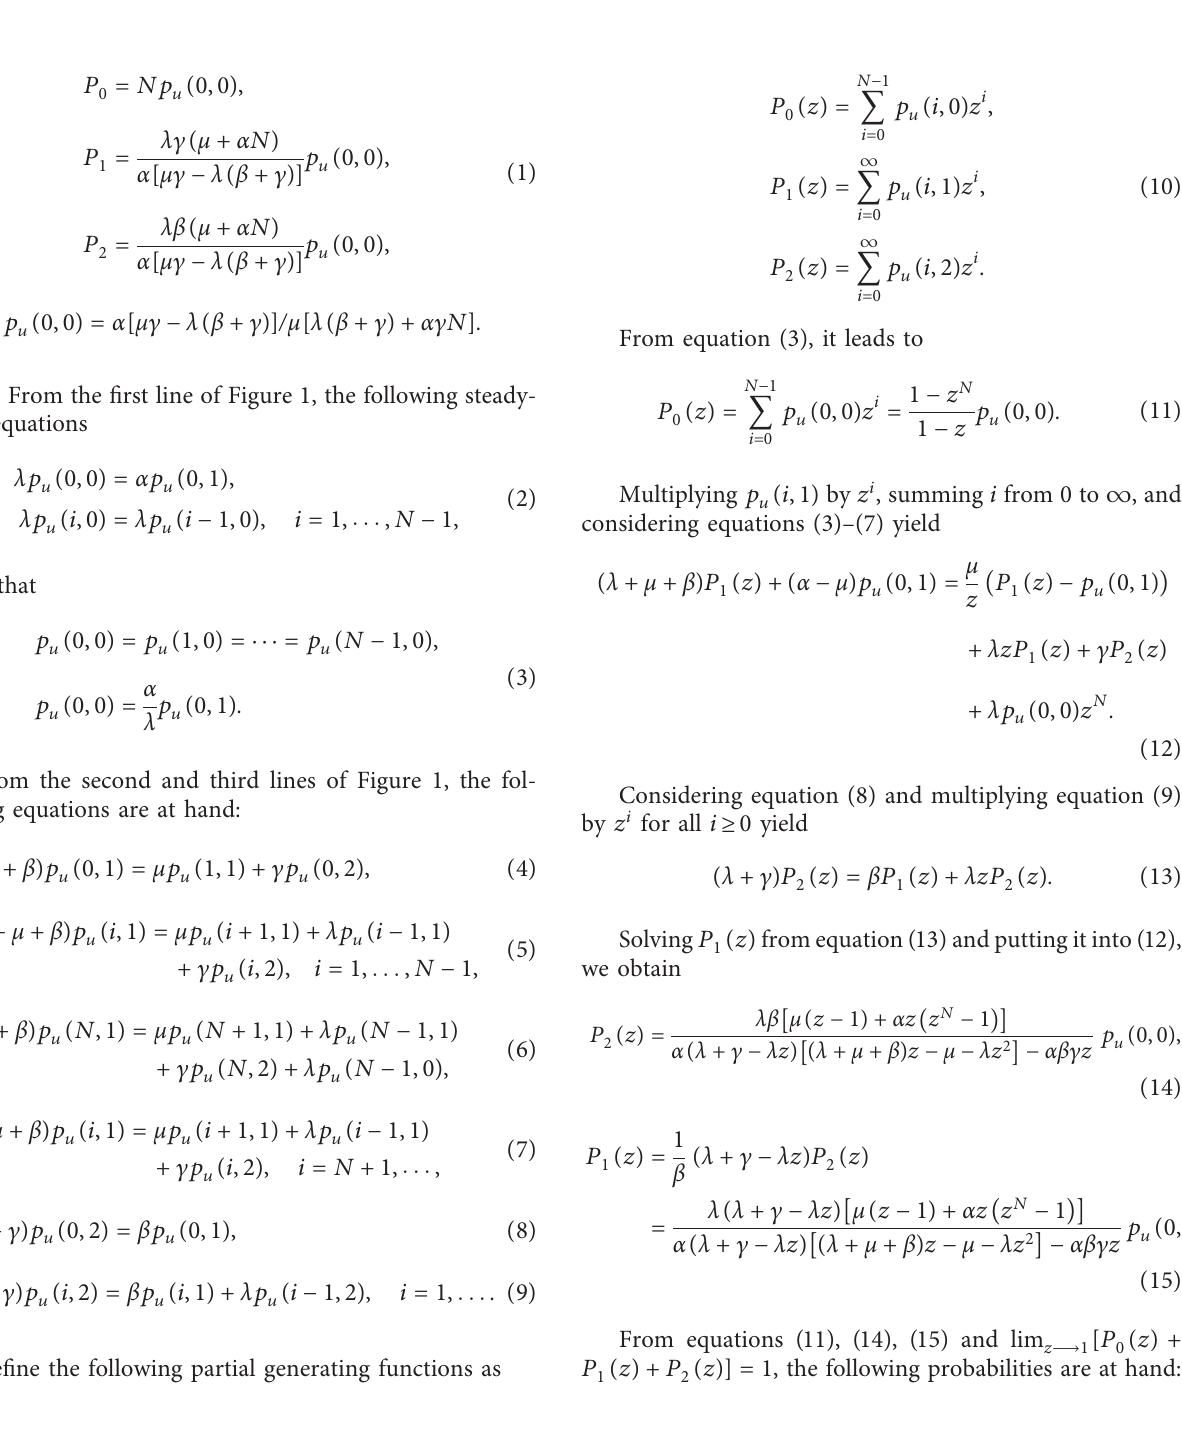
Figure 1: Transition rate diagram of the system in the unobservable